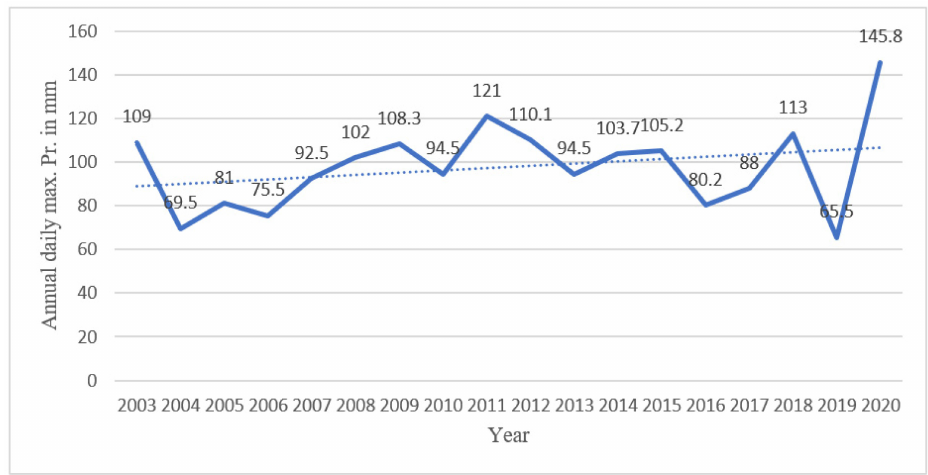
Figure A8. Observed annual daily maximum precipitation of